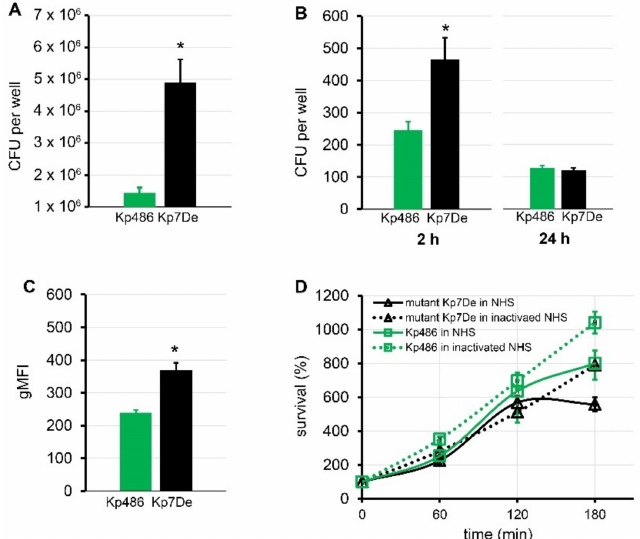
Figure 4. Comparison of virulence of capsule-deficient Kp7De mutant and its parental Kp486 strain. Adhesion ( A ) and time-dependent internalization ( B ) by the A549 lung epithelial cells expressed in CFU per well and shown as the mean ± SEM ( n = 4). ( C ) Phagocytosis by the human monocyte cell line THP1 determined by flow cytometry. UV-killed FITC-labeled bacterial cells were mixed with monocytes at a 100:1 ratio. Quantification of cellular uptake of bacterial cells by phagocytes is expressed as the geometric mean fluorescence intensity (gMFI) from the gated sample with phagocytosing cells ± SEM ( n = 3). ( D ) Time-dependent bactericidal effect of 50% NHS or heat- inactivated NHS for 3 h at 37 ◦ C. The percentage of survival was determined as the number of bacteria that survived relatively to the initial bacterial loading ( n = 3). Asterisks indicate a statistically significant difference ( p <